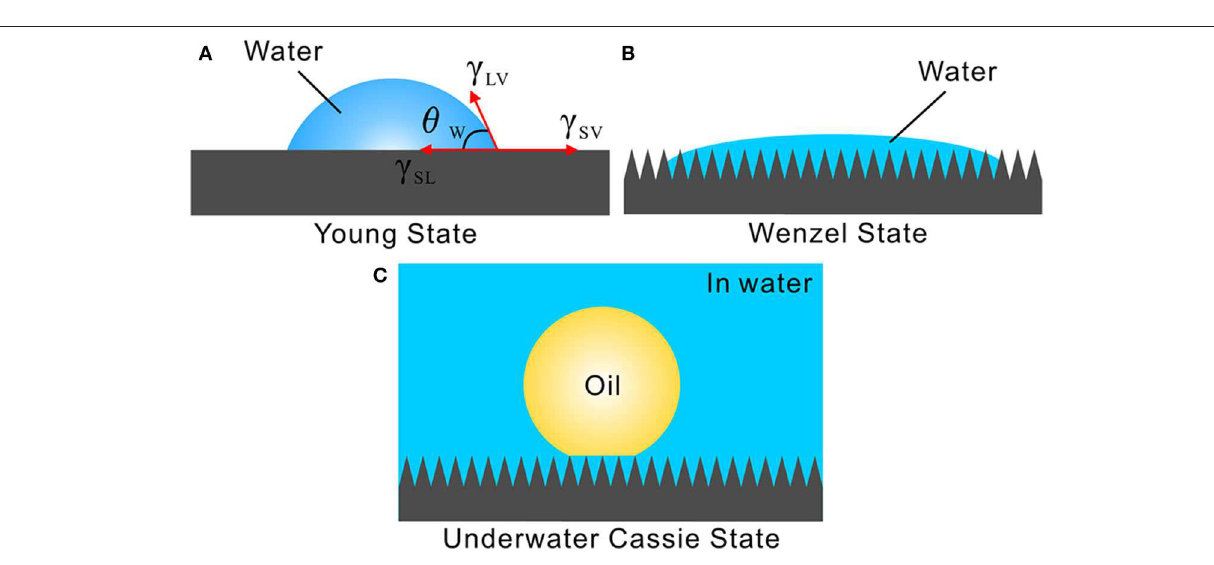
paper and zeolite layer as the separating materials,